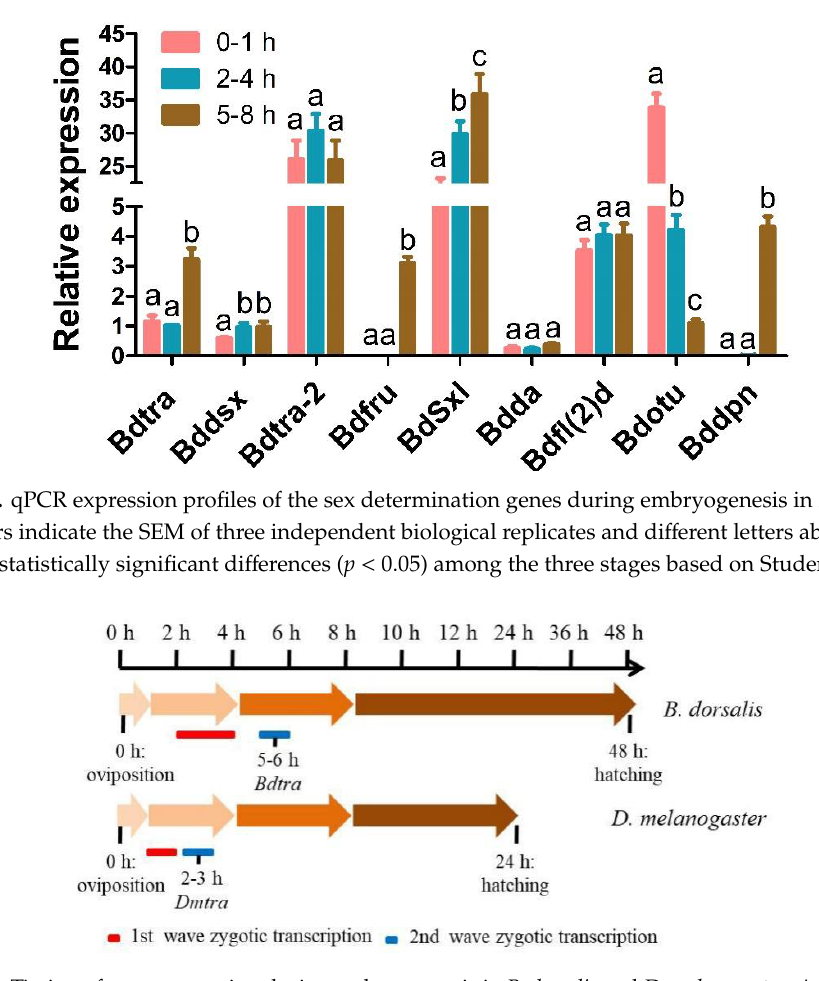
Figure 8. Timing of gene expression during embryogenesis in B. dorsalis and D. melanogaster . A schematic